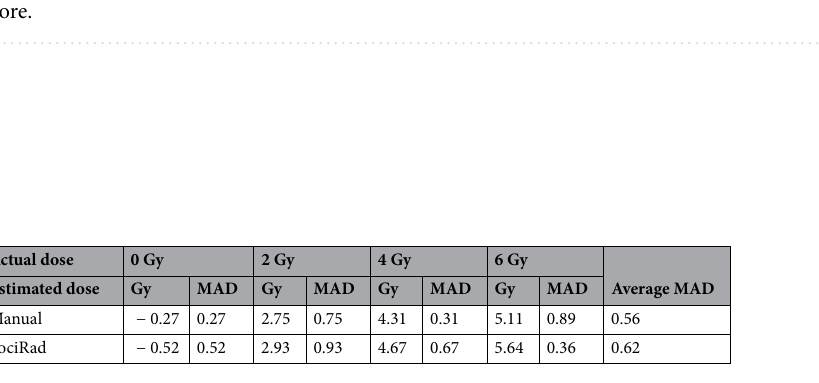
Table 2. Estimated doses and MAD values obtained from manual and FociRad scoring. MAD = mean absolute